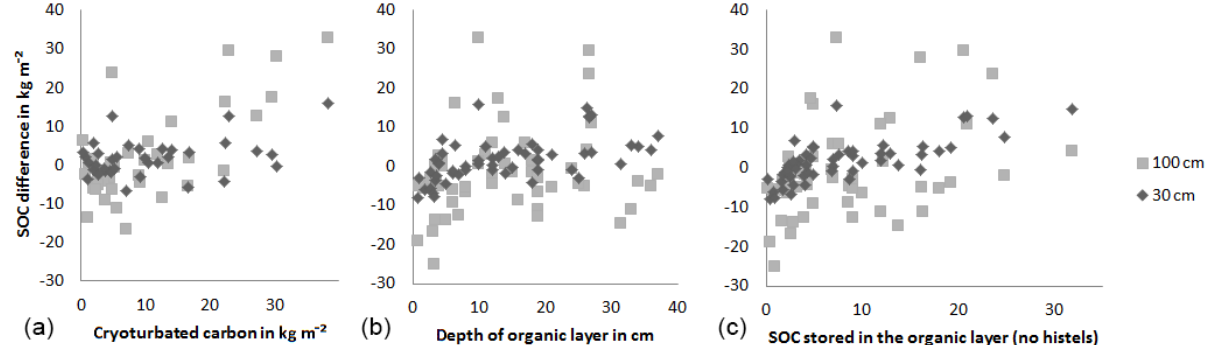
Figure 11. SOC differences between results from ENVISAT ASAR GM and pedon (point) measurements from Kytalyk and Tulemalu in comparison to amount of cryoturbated carbon (left; R 2 0.5 and 0.14 for 100 and 30cm respectively), depth of organic layer (middle; R 2 0.59 and 0.62 for 100 and 30cm respectively) and SOC stored in the organic layer (right; R 2 0.66 and 0.69 for 100 and 30cm